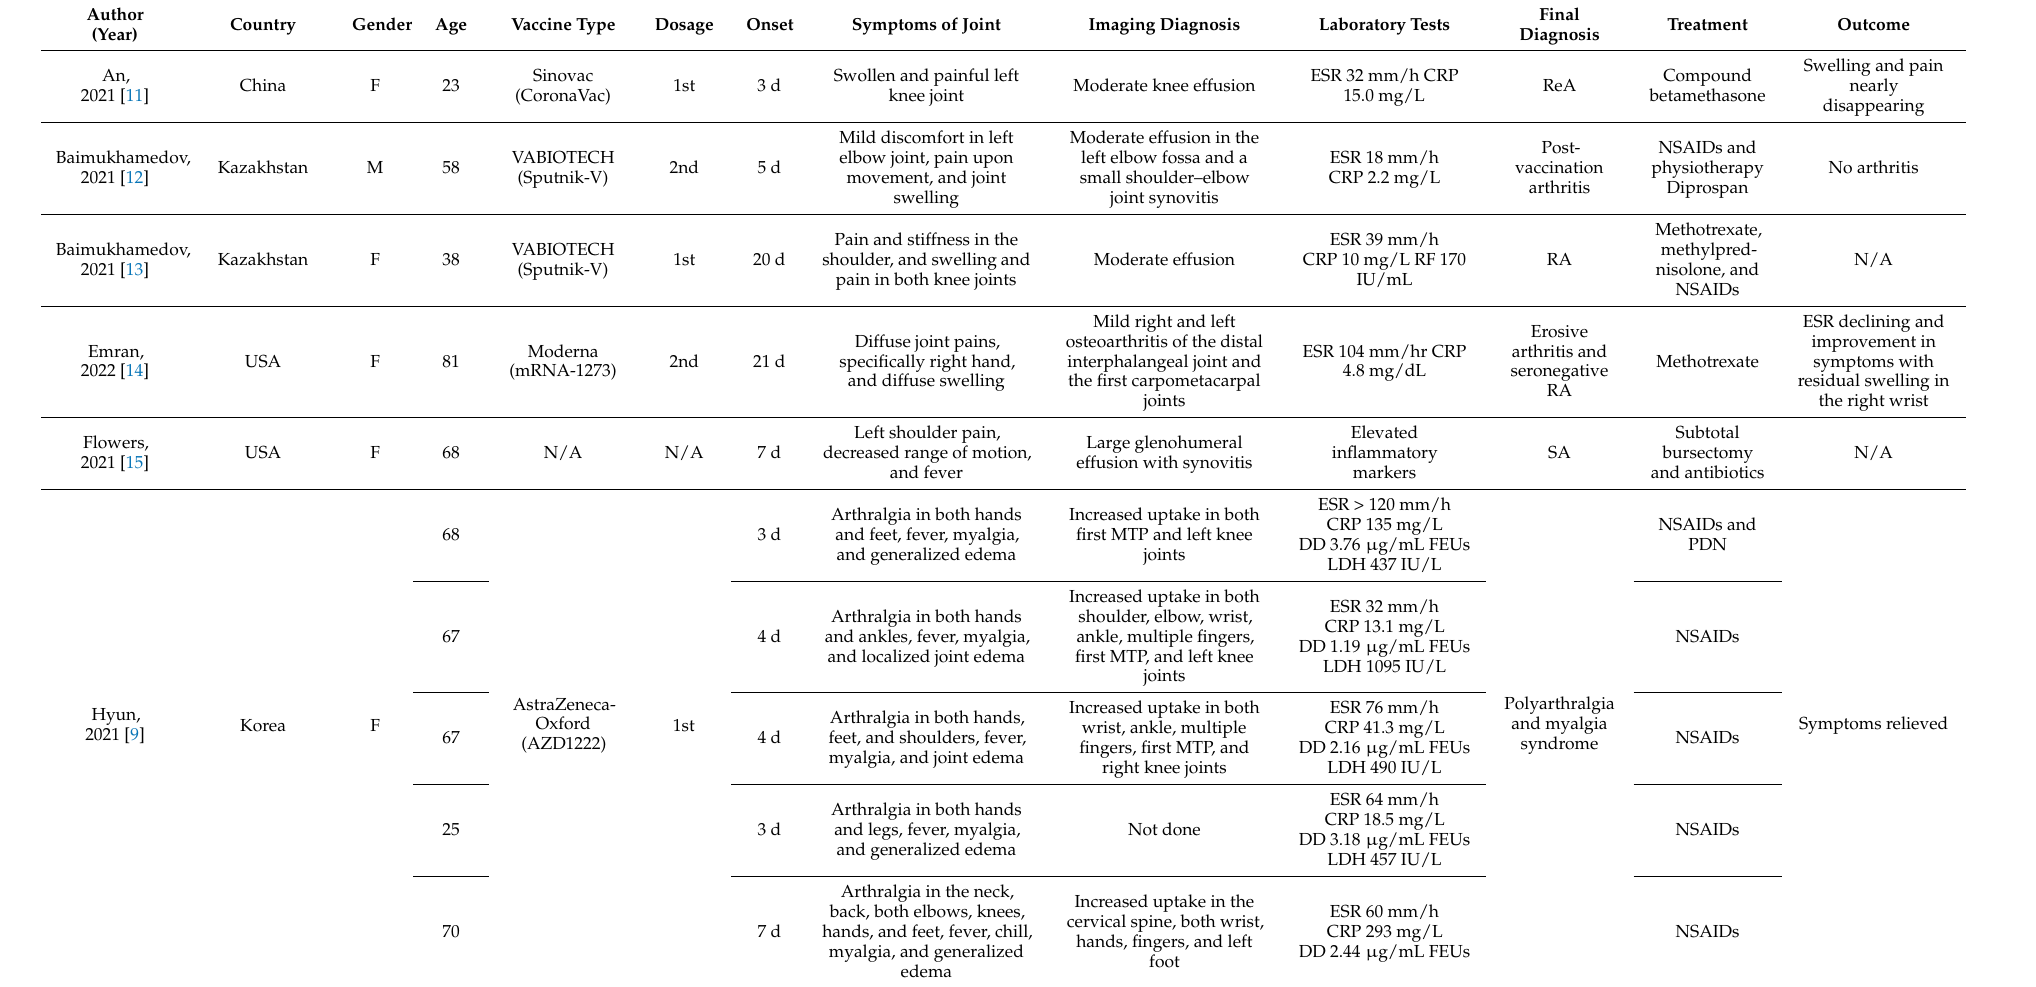
Table 1. Characteristics of new-onset arthritis after COVID